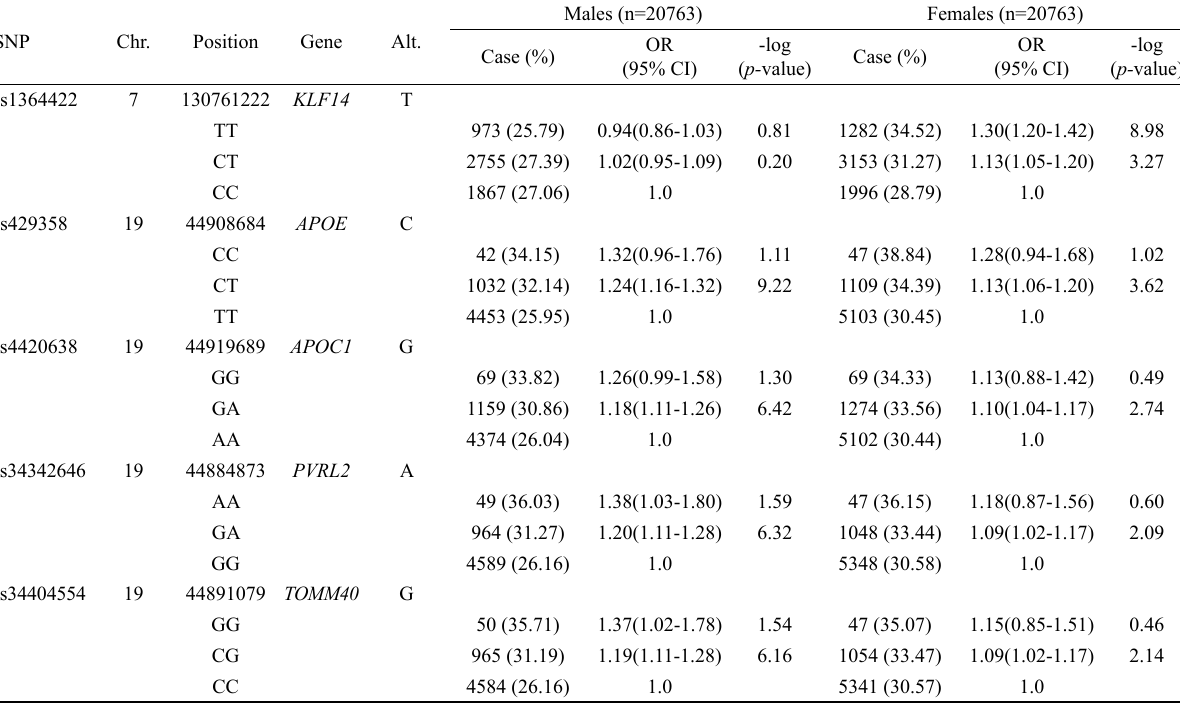
Table 2 – ORs and allele information of polymorphisms which were sex-specific related to low-HDL-C.